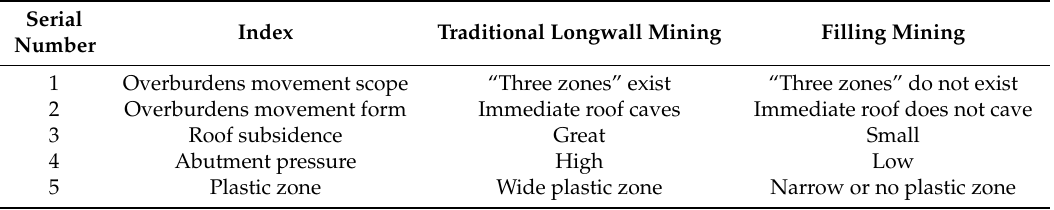
Table 1. Strata movement characteristics of longwall caving mining and backfill mining.